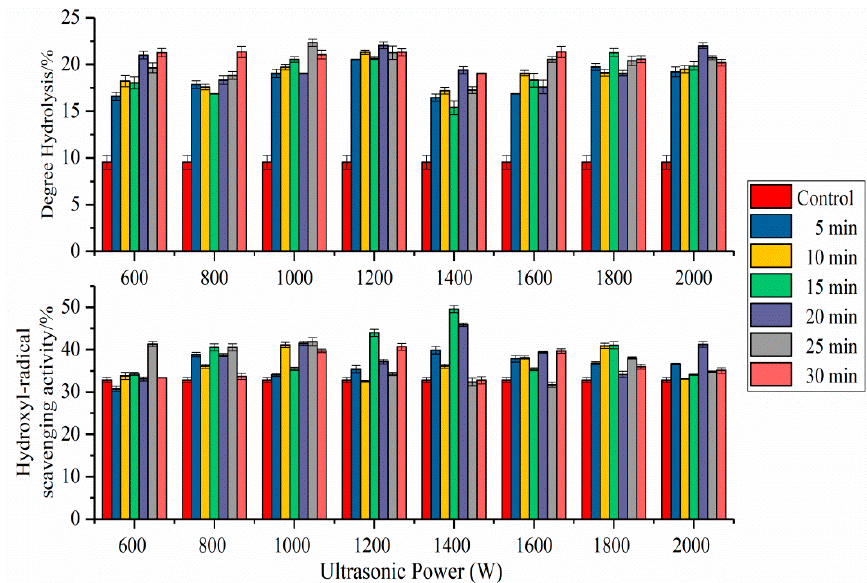
Figure 8. Effect of pretreatment on enzymatic hydrolysis and hydroxyl-radical scavenging activity of the SPI hydrolysates. Data are the averages of three replications ± standard deviation.